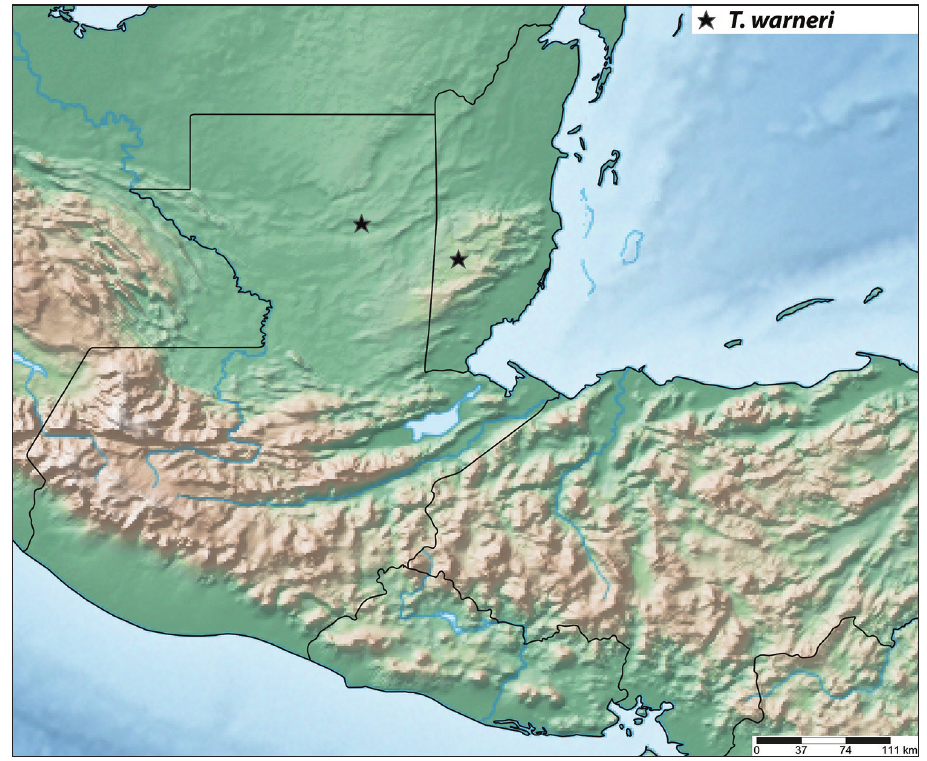
Figure 57. Distribution map in Guatemala and Belize for Trigonopeltastes warneri sp. n. ( 